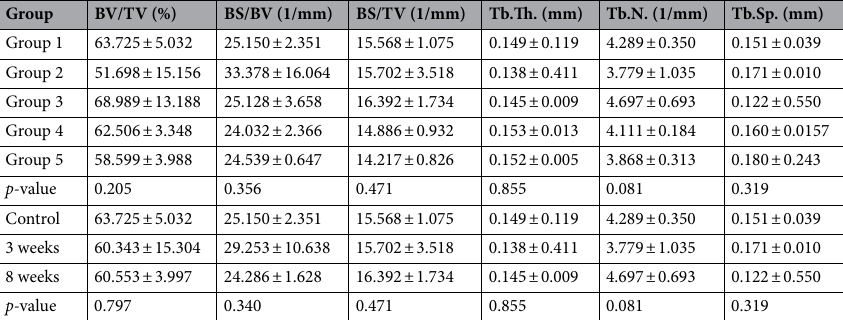
Table 4. Micro-CT bone morphometric parameters from the oral administration model groups showing the effects of bisphosphonate on the bone in the groups with a medication discontinuation compared with the control group. The statistical analysis was performed using ANOVA. The data are depicted as the mean ± standard deviation. BV/TV bone volume/total volume (bone volume fraction), BS/BV bone surface/ segmented bone volume (specific bone surface), BS/TV bone surface/total volume (bone surface density), Tb. Th. trabecular thickness, Tb.N. trabecular number, Tb.Sp. trabecular separation.